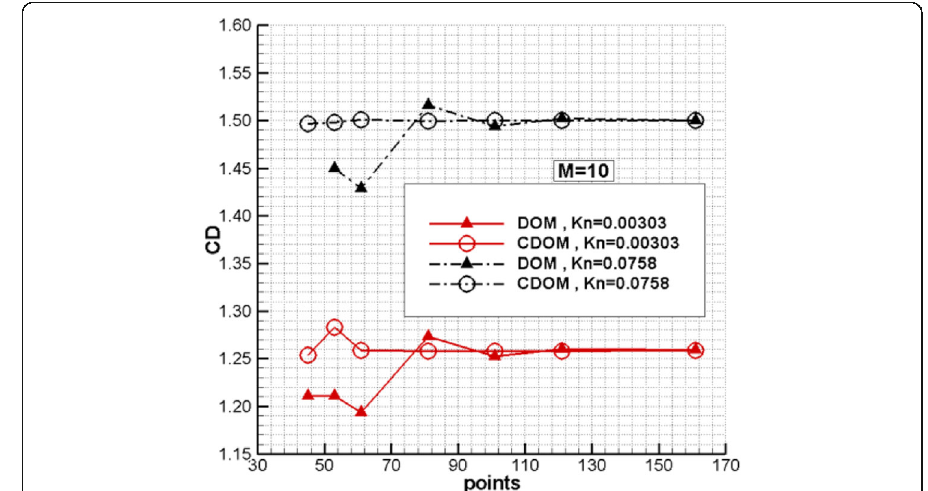
Fig. 9 Cylinder drag coefficient vs points in u(v) direction